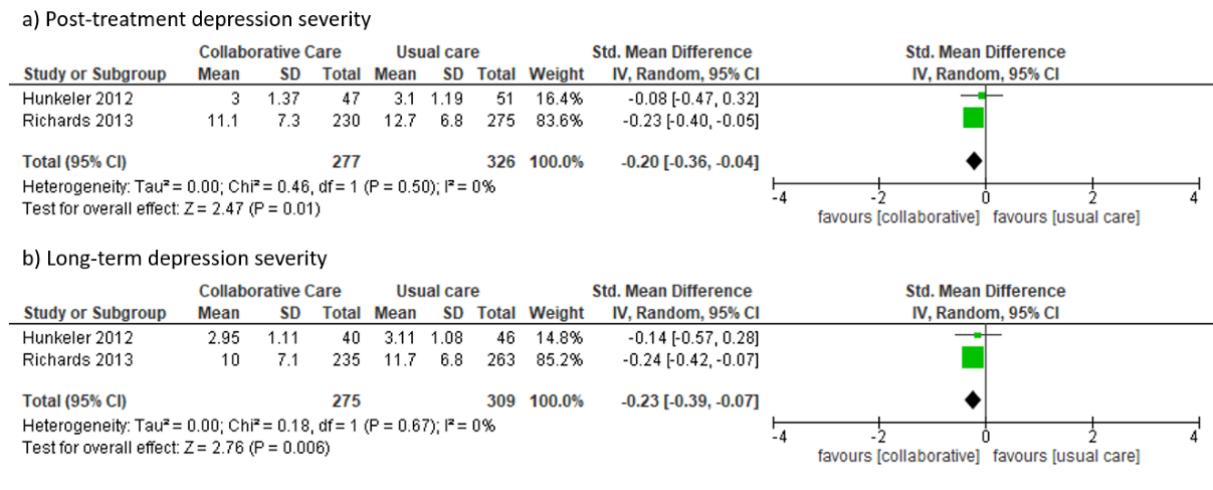
Figure 11. Forest plots for collaborative care